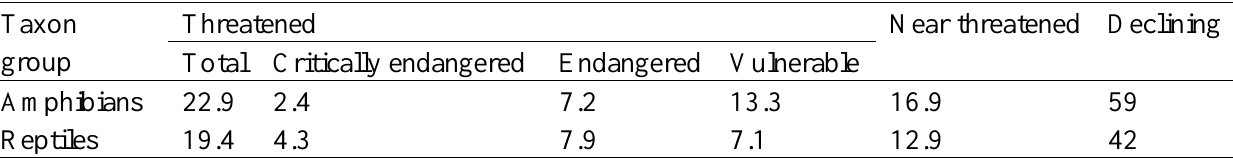
Table 2. (B) Risk comparisons (Europe). Data from [13] and [14]. All values are % of total native species.